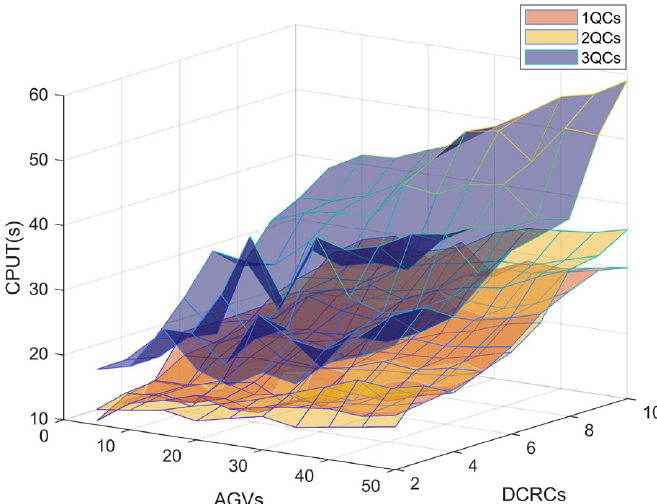
Figure 12. CPUT(s).